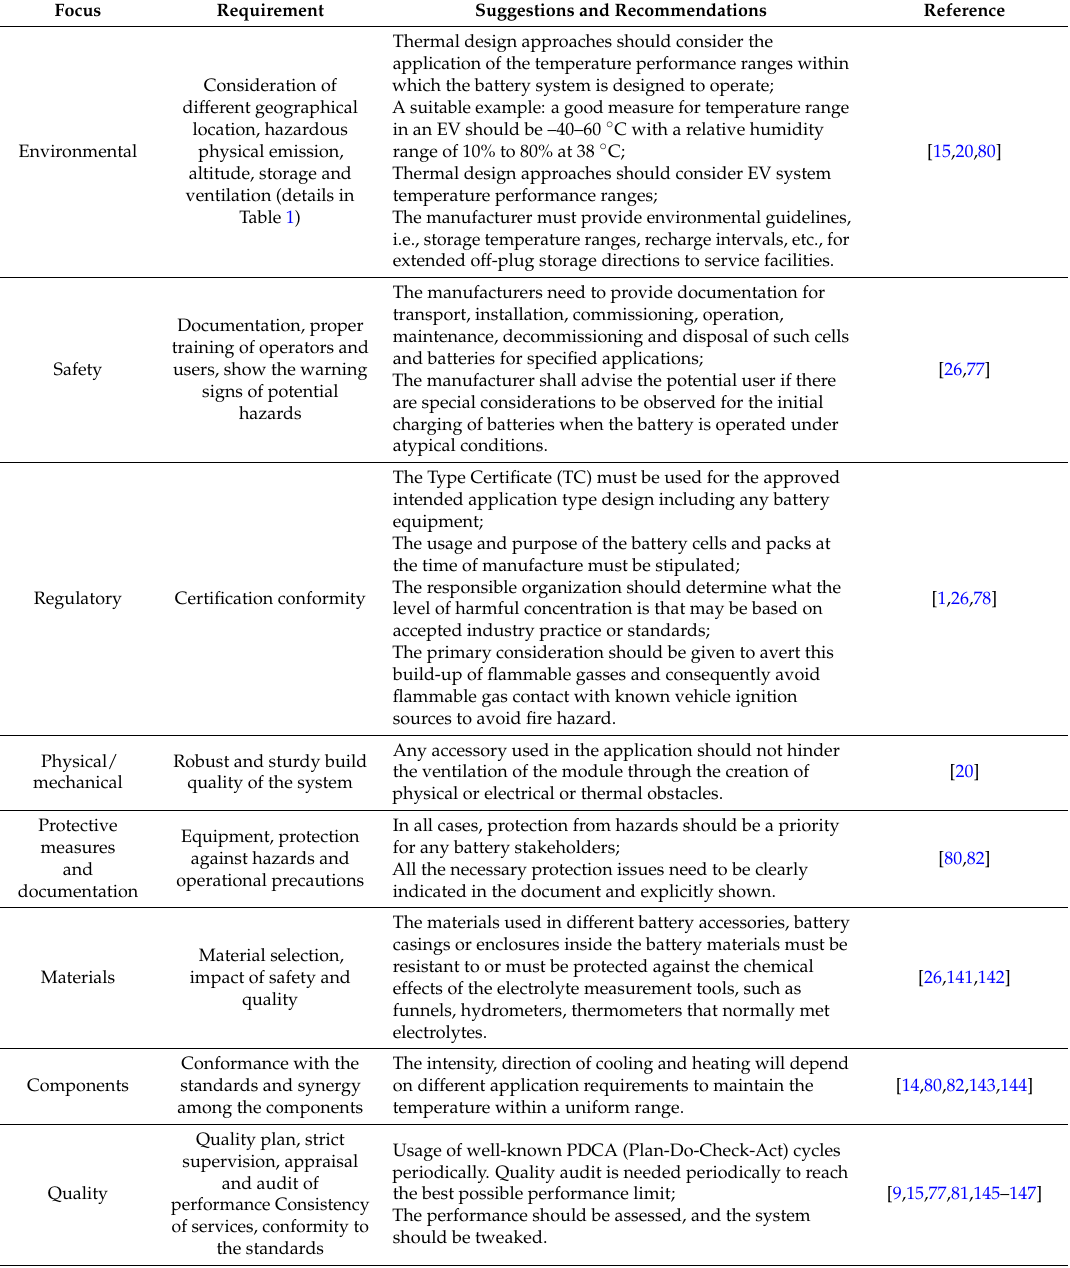
Table 7. Suggestions and Recommendations for an Effective